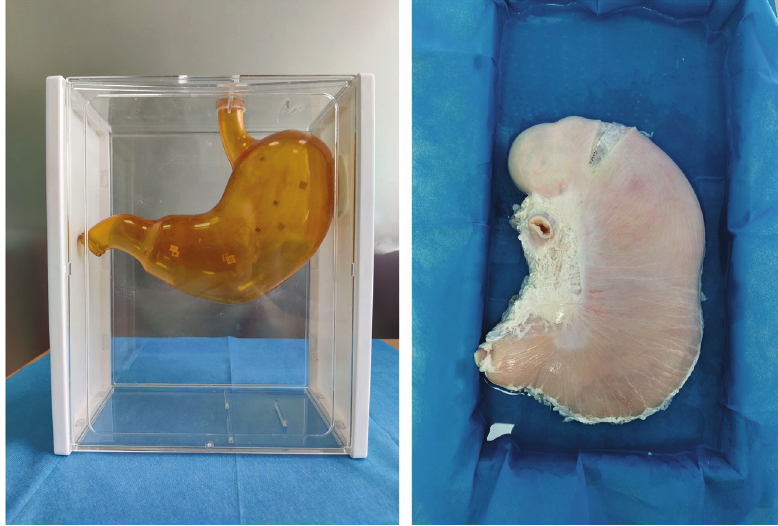
Figure 2: Plastic stomach model and excised porcine stomach model.